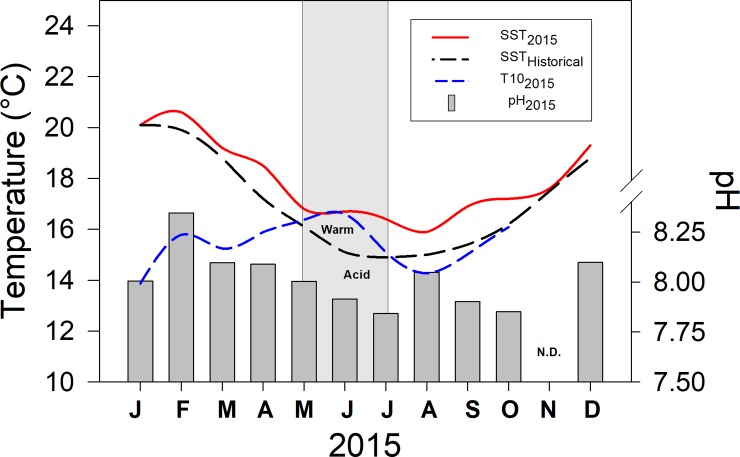
Historical oceanography vs. “El Niño” 2015.Sea surface temperature during 2015 (SST2015) and historical data (1981–2010, SSTHistorical) are plotted along with temperature (T10) and pH measured in this study.